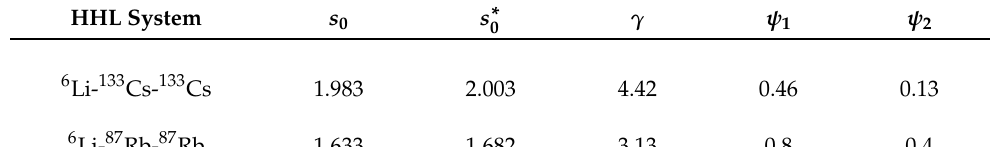
∗ 0 and s 0 are calculated in Ref. [51].